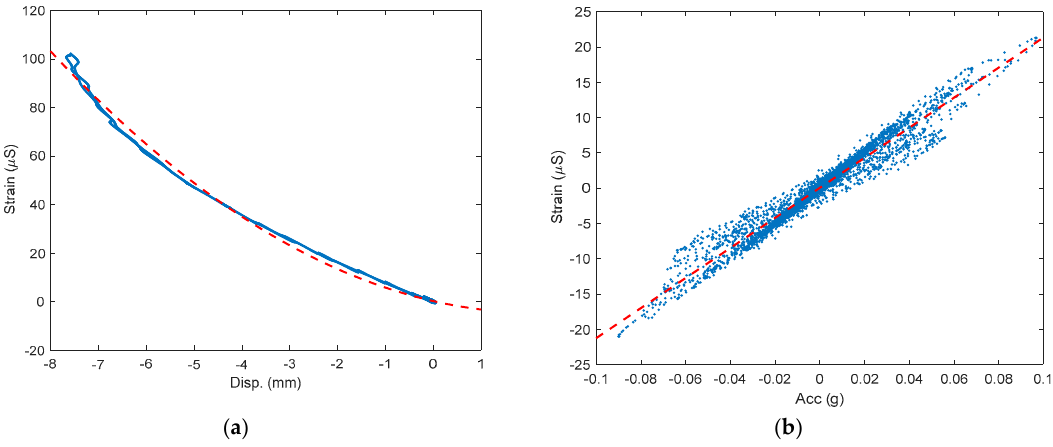
Figure 7. Acceleration and dynamic strains measurements.